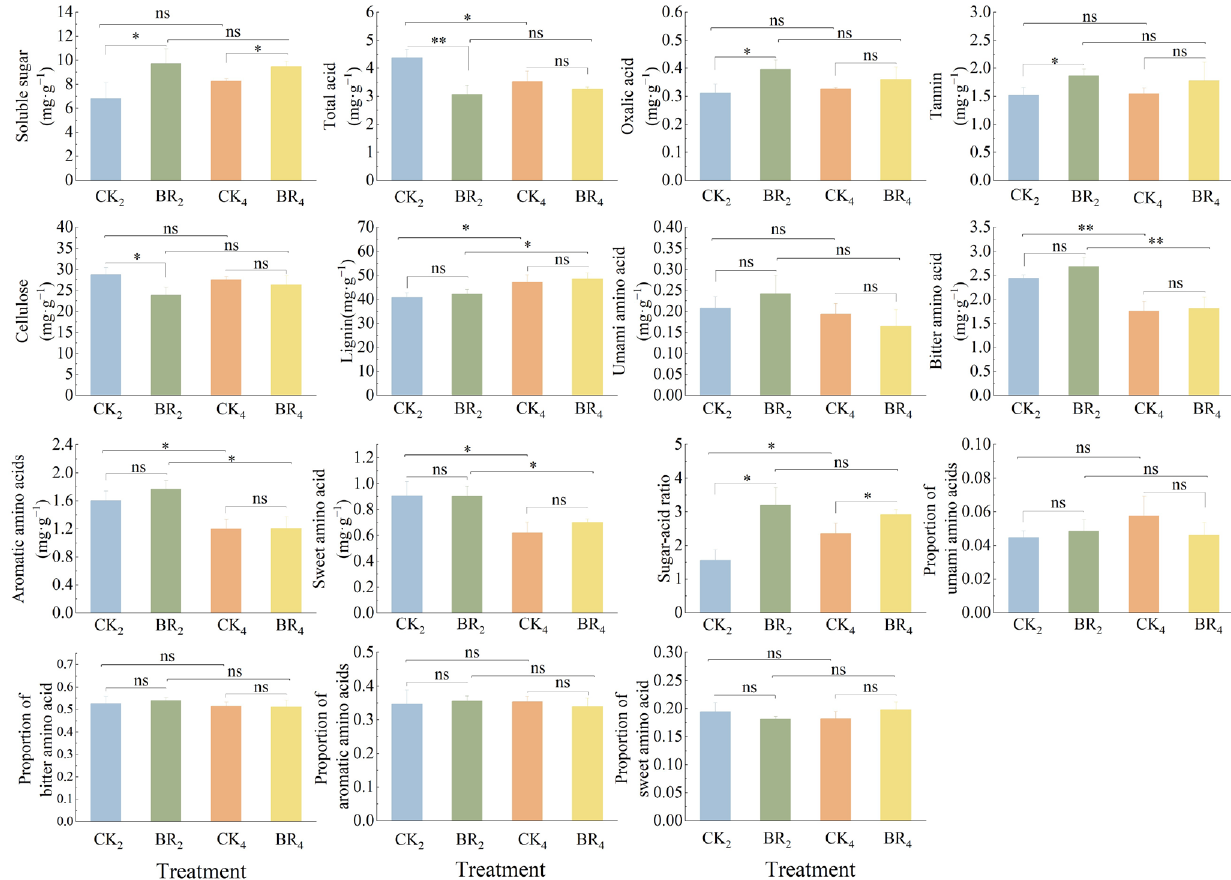
Figure 5. Flavor and roughness substances of Ph. violascens shoots after sheath blade removal. CK 2 : natural growth after 2 d; BR 2 : sheath blade removal after 2 d; CK 4 : natural growth after 4 d; BR 4 : sheath blade removal after 4 d; ns: p > 0.05; *: p < 0.05; ** : p < 0.01.